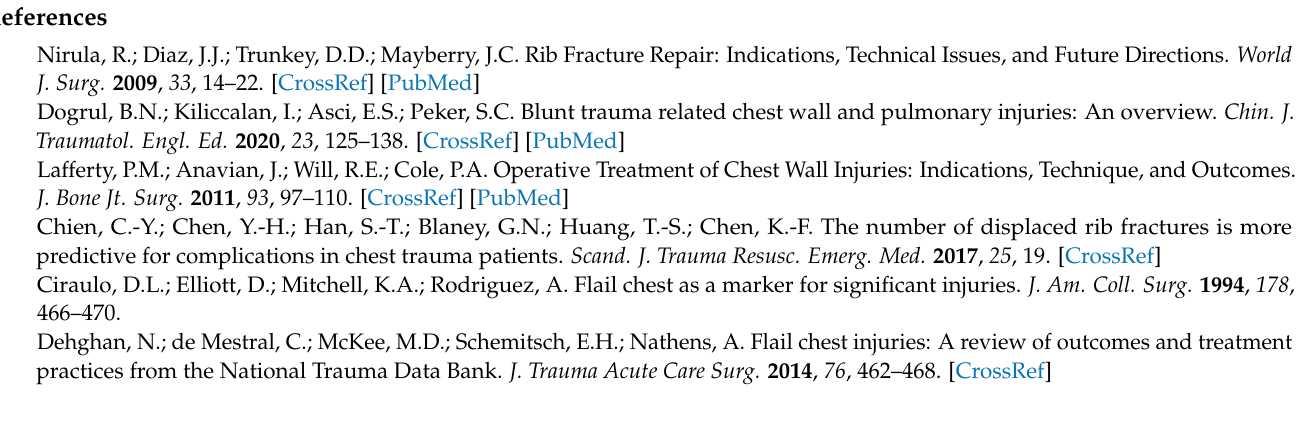
Table S2: Post-surgical